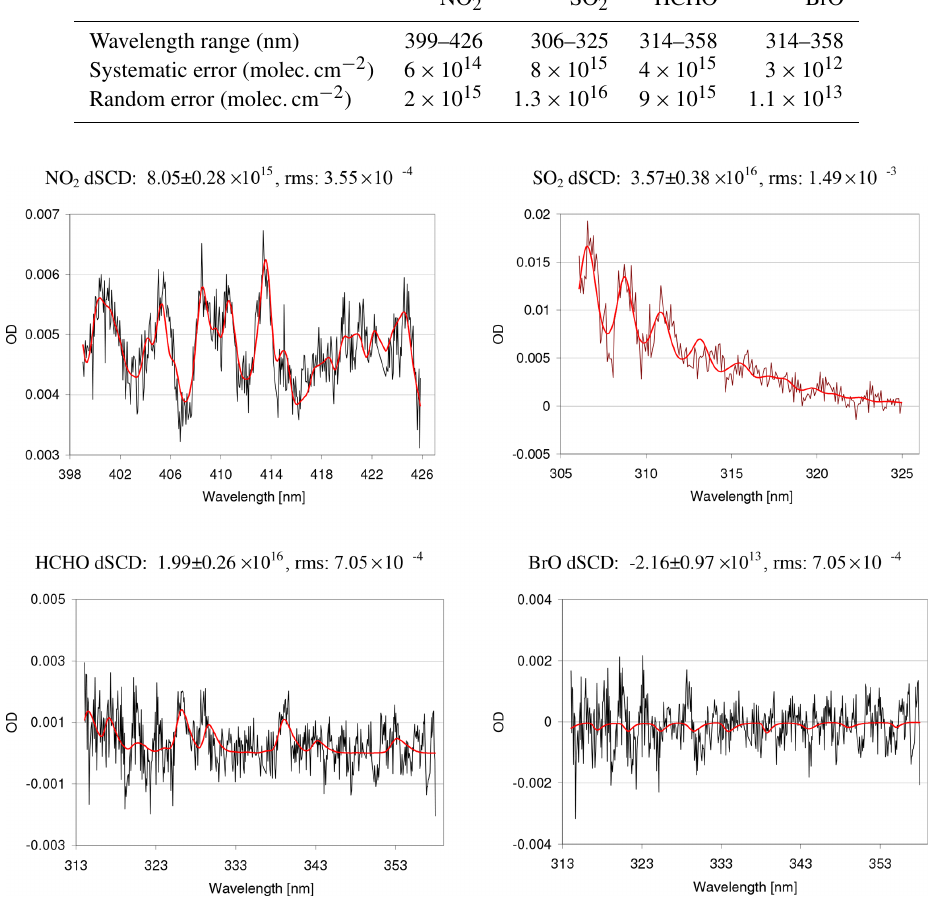
Figure 2. Fit result for NO 2 , SO 2 , HCHO, and BrO for a spectrum (average of 10 original spectra) taken on 13 May 2013 (00:34–04:19) at 1 ◦ elevation. On this day, enhanced absorptions of SO 2 and NO 2 were